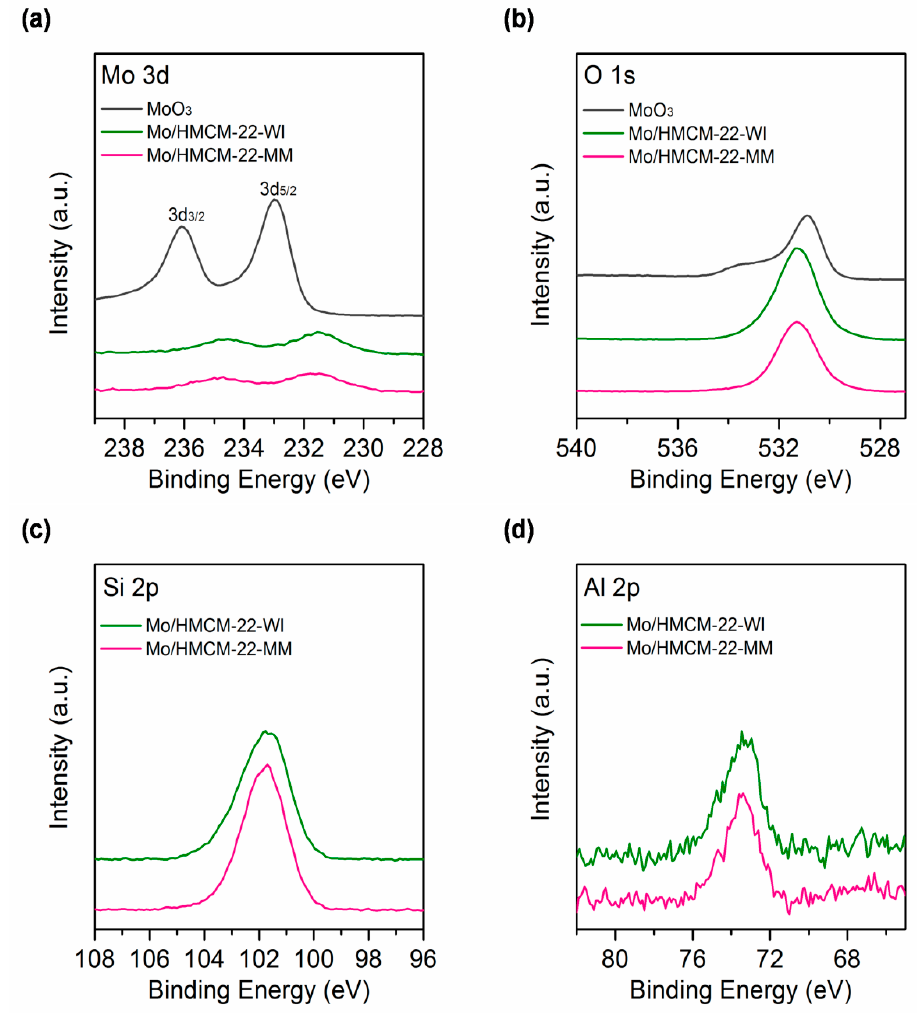
Figure 7. XPS analysis of the MoO 3 , Mo/HMCM-22-WI and Mo/HMCM-22-MM samples. ( a ) Mo 3d region for the MoO 3 , Mo/HMCM-22-WI and Mo/HMCM-22-MM; ( b ) O 1s region for the MoO 3 , Mo/HMCM-22-WI and Mo/HMCM-22-MM; ( c ) Si 2p region for the Mo/HMCM-22-WI and Mo/HMCM-22-MM and ( d ) Al 2p region for the Mo/HMCM-22-WI and